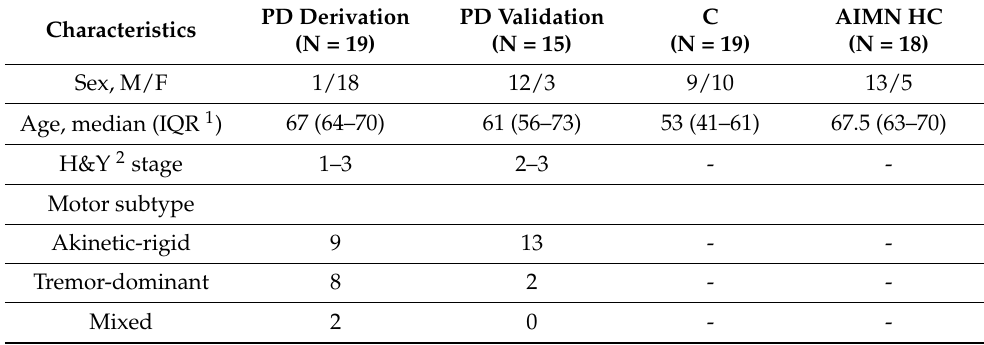
Table A2. Demographic and clinical characteristics of the PD patients and control group